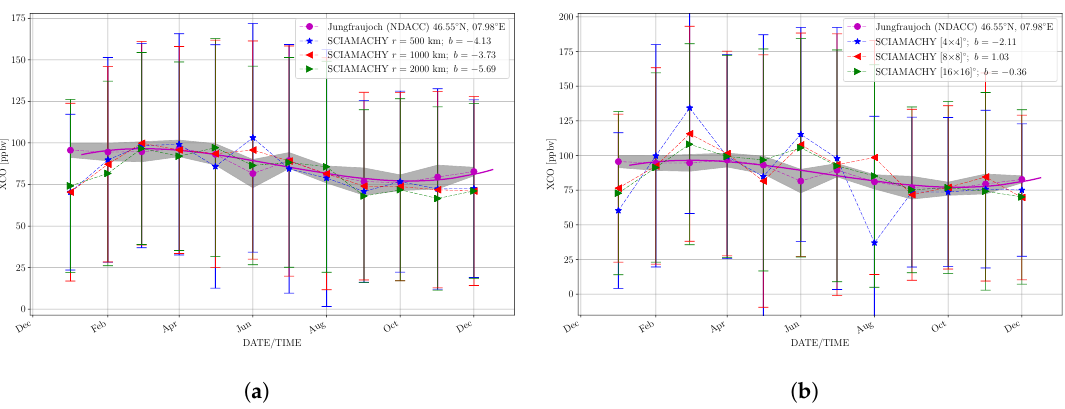
Figure 5. xCO averages for circle- and square-shaped sampling areas. ( a ) Averages of SCIAMACHY xCO values calculated for various distances from the reference site Jungfraujoch in 2003; ( b ) xCO averages within given latitudes and longitudes of the g-b site. Here, [ 4 4 ] ◦ designates a square-shaped × object with an extent of 2 ◦ in latitude and longitude from the reference site. SCIAMACHY ± observations within the circle-shaped sampling areas show better agreement for most cases in 2003. Note the different range of the y-axis.